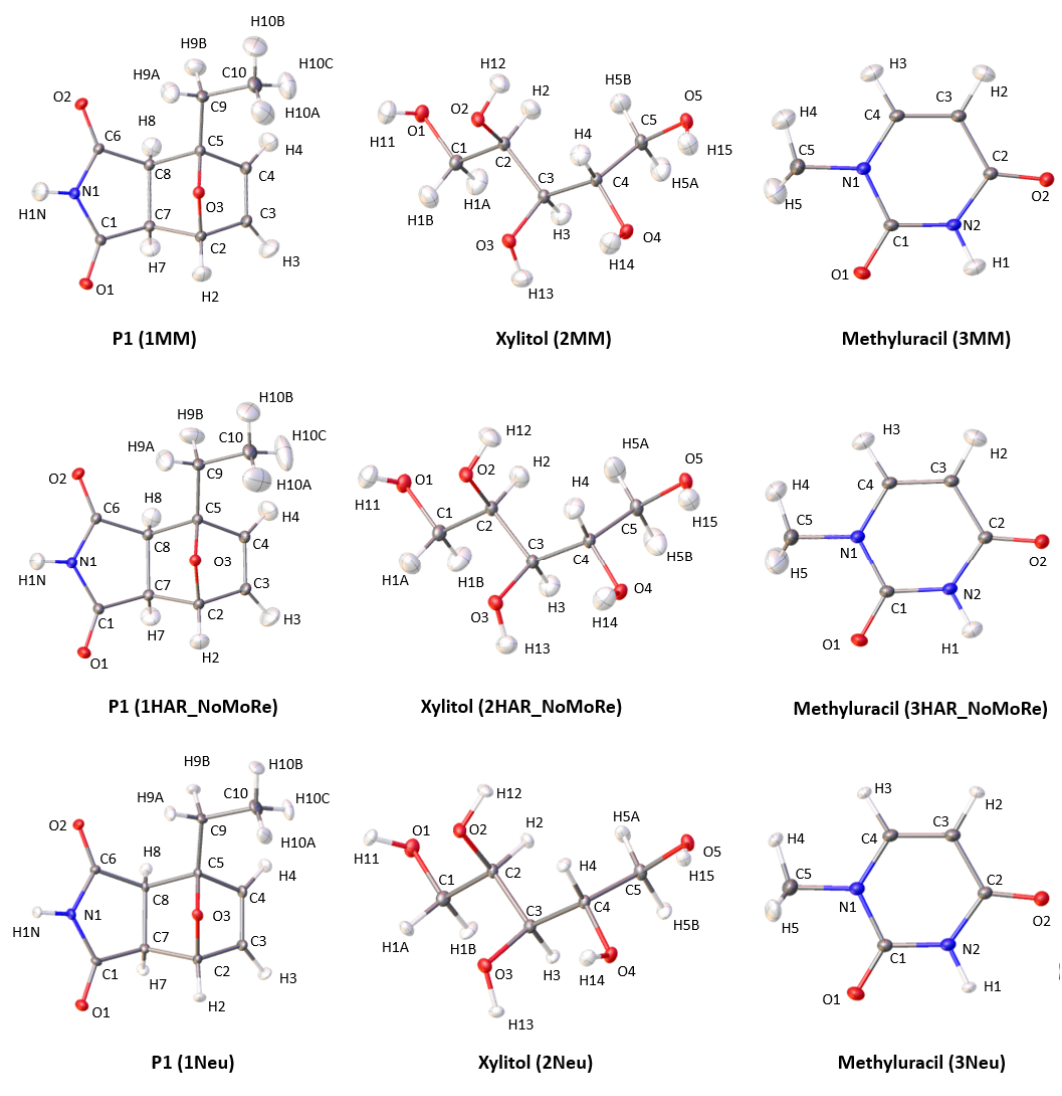
Figure 1. Labelling of atoms and visualisation and comparison of atomic ADPs in molecular structures of the studied compounds 1 , 2 , and 3 obtained with the MM and HAR–NoMoRe refinements and neutron diffraction. Anisotropic atomic displacement ellipsoids are drawn at the 50% probability level.